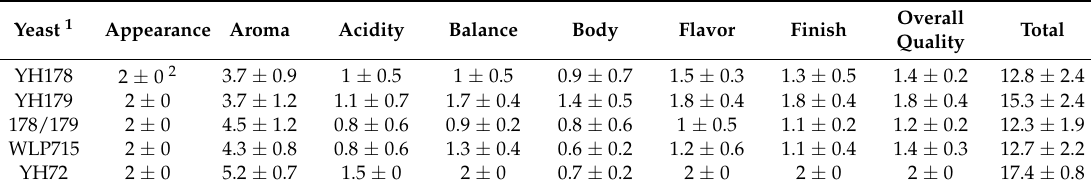
Table 2. Sensory evaluation of mead